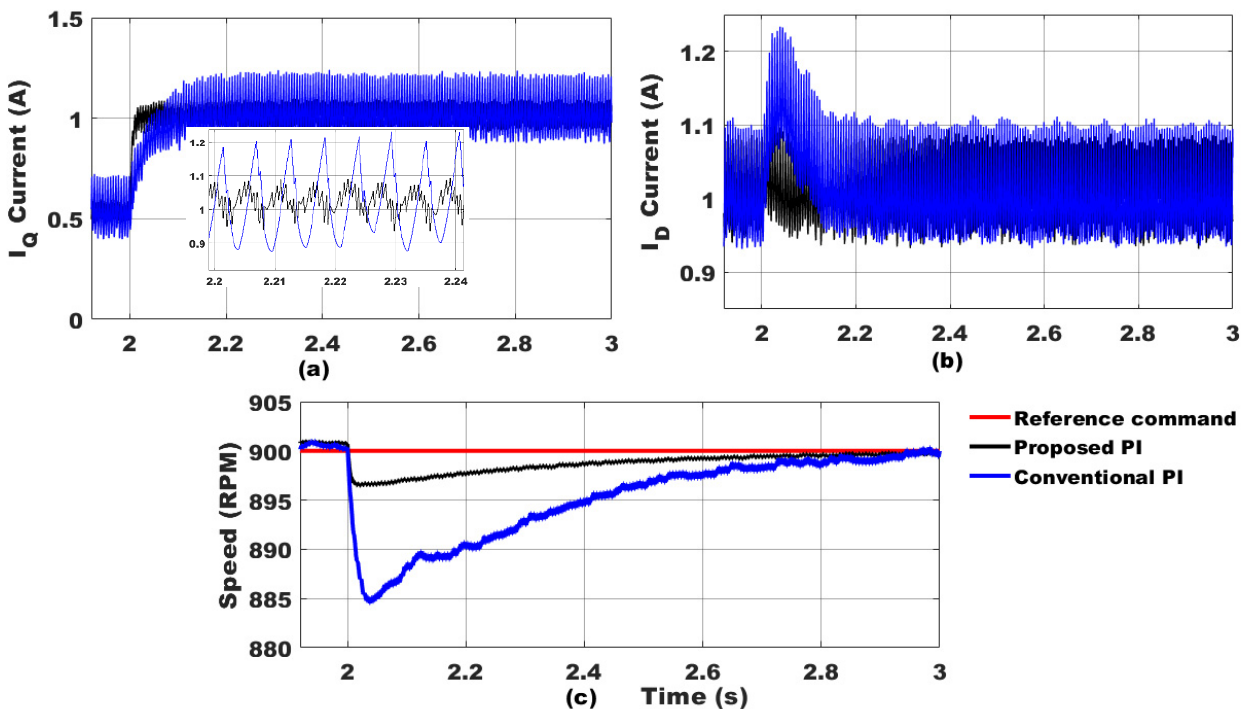
Figure 10. Comparison of robust regulatory performance of SynRM drive: ( a ) Regulation of I q currents to their desired I q values, ( b ) Regulation of I d currents to their desired I d values, ( c ) Regulation of speed variables, under load torque disturbance.